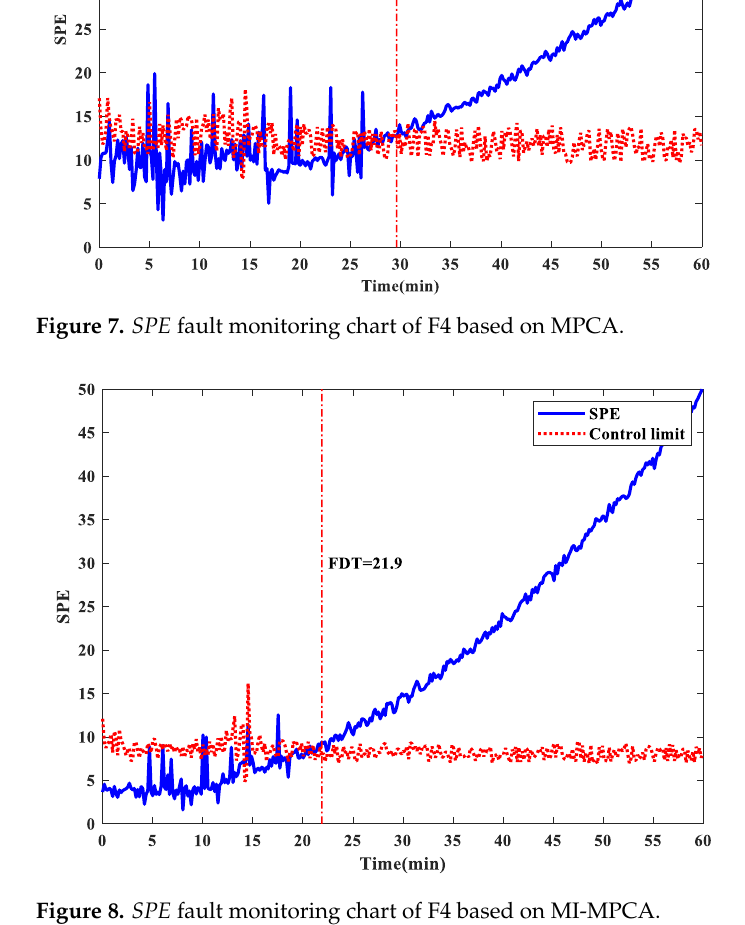
Figure 9. SPE fault monitoring chart of F4 based on NMI-WMPCA. 5.2.2. Monitoring Results and Analysis of Abnormal Operation of the Stirring Motor In order to simulate the abnormal operation condition of the plasticizing process caused by the abnormal working condition of the stirring shaft, the faulty batch F5 reduces the working voltage of the stirring motor and makes it operate under the condition of under-voltage. It is known from the process mechanism that failure to reach the rated voltage will cause the motor speed to drop and the current to increase, and will cause the motor temperature to rise, which can burn the motor and cause a fire in severe cases. Due to the potential safety hazard in the production of this fault, the under-voltage amplitude was set to 10% to ensure the safety of the process during the test, and the run- ning time only lasted for 20 min. Because of the short running time of the faulty batch, the 𝑇 2 and SPE statistics of the traditional MPCA did not form an effective monitoring for it. So, Table 5 only shows the monitoring results of the faulty batch F5 by MI-MPCA and the algorithm in this paper. Among them, as shown in Figure 10, the SPE statistics of MI- MPCA detect the fault just before the end of operation (18.8 min). The monitoring results of NMI-WMPCA are shown in Figure 11. The 𝐵𝐼𝑆 𝑆𝑃𝐸 statistic detects the abnormal work- ing condition after 4.1 min of operation, and the fault warning is given in advance. This will force maintenance personnel to conduct troubleshooting, so as to effectively avoid the occurrence of safety accidents.